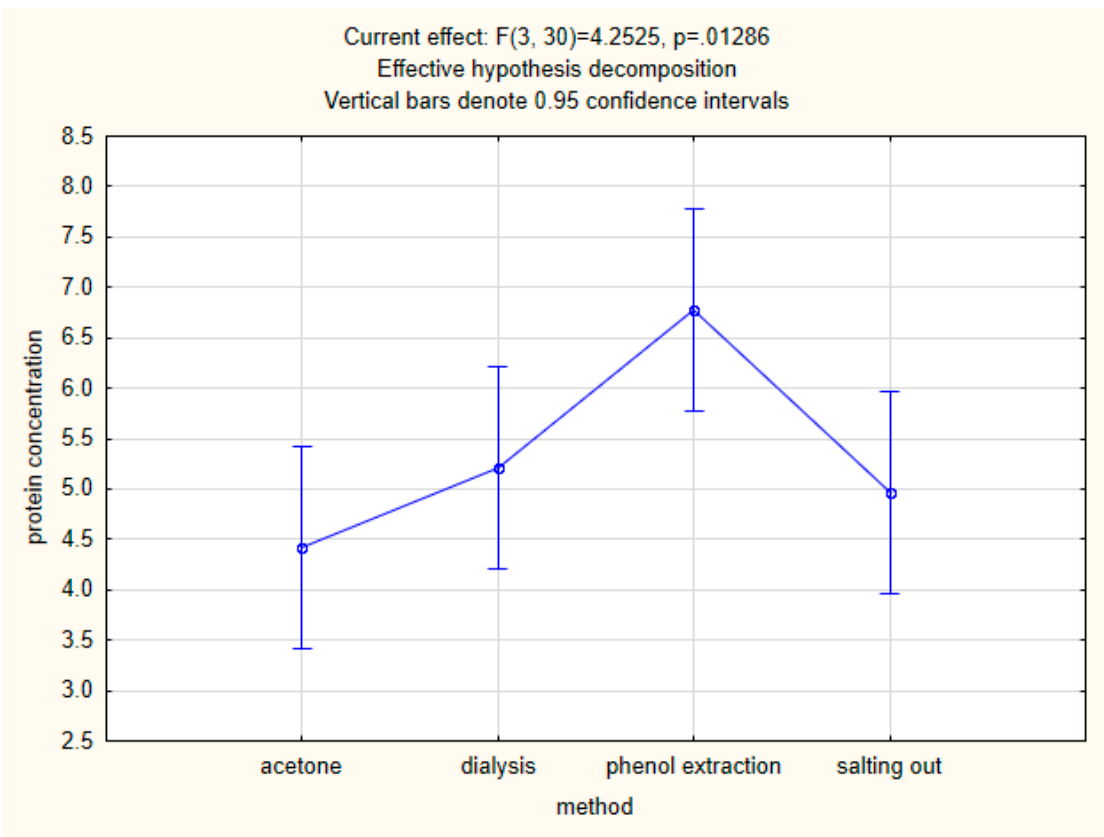
ffi ciency of the phenolic